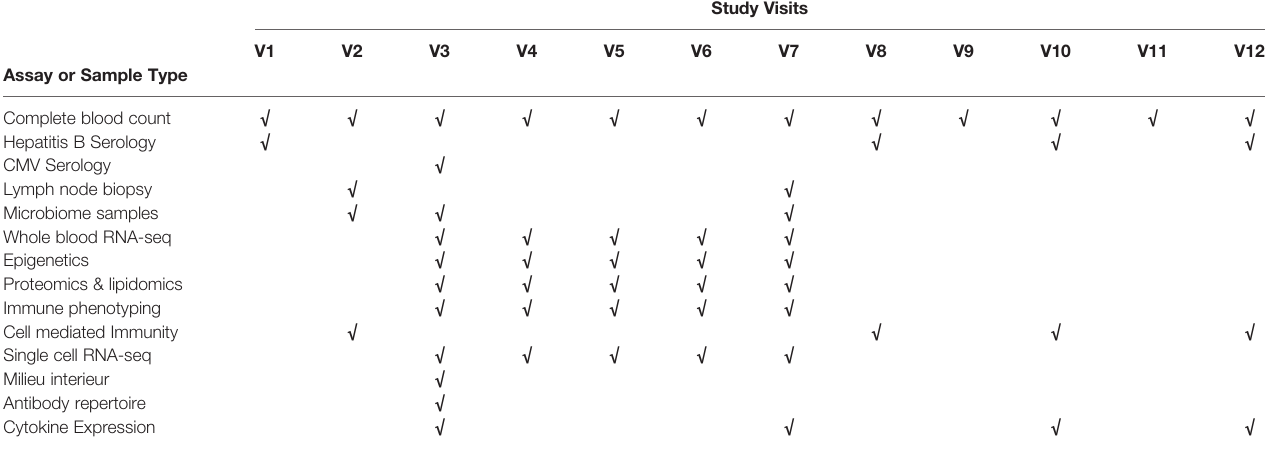
TABLE 2 | Sample collection details per omic assay and study